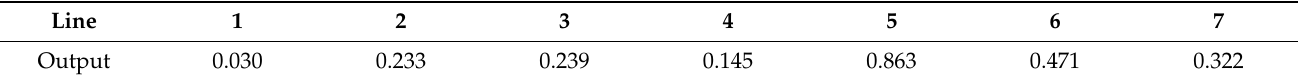
Table 3. Output of the FLS model for Figure